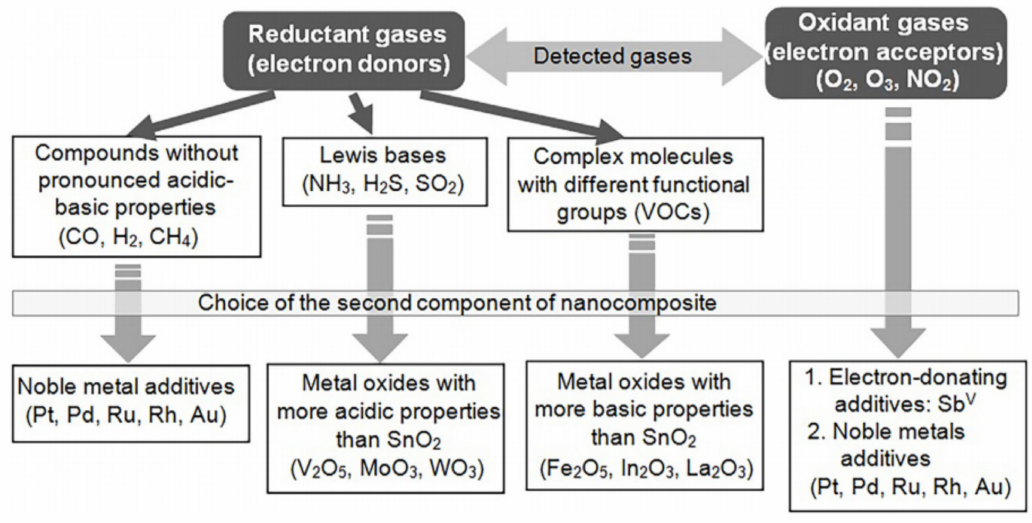
Figure 19. Choice of the second component of SnO 2 -based nanocomposite with allowance for the properties of the detected gas. Reprinted with permission from [60]. Copyright 2017 Elsevier. Idea and data from Ref.